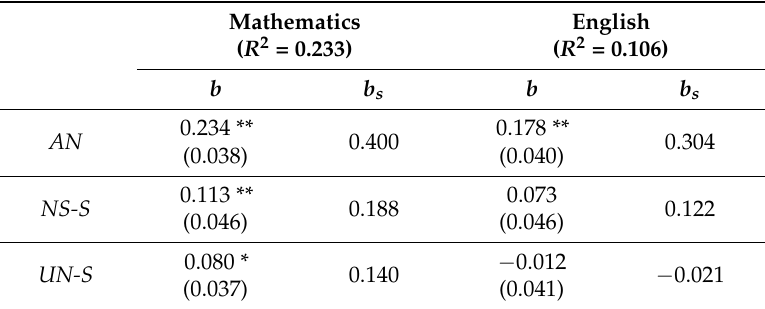
Table 7. Multivariate Regression analyses with the Mathematics and English Grades as Dependent Variables and the Three Factors of the Bifactor( S -1) Model as Independent Variables (Reference Facet = Verbal Analogies).